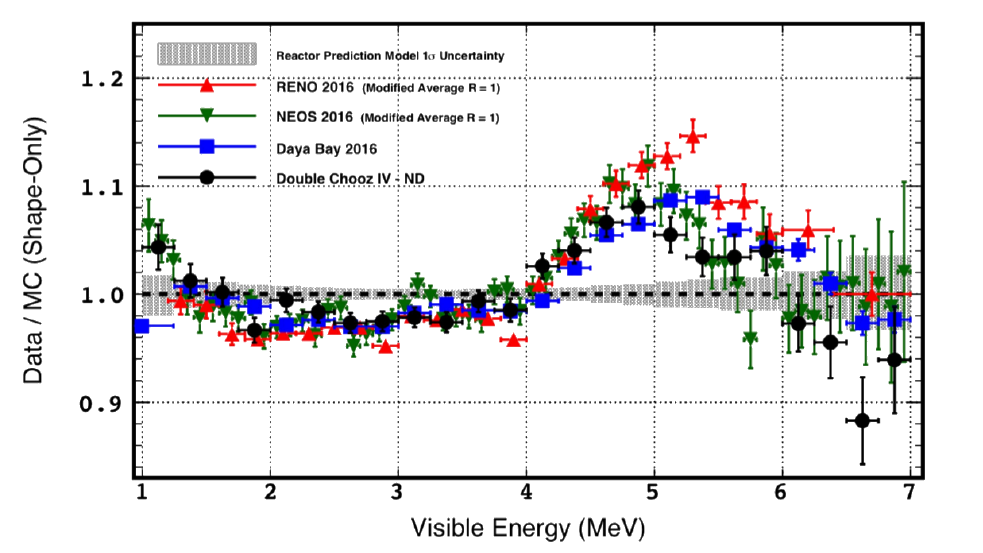
Figure 3. Comparison of spectral shape measurements of the LEU experiments. All results are normalised such that the average ratio equals unity. Reprinted from [51], ©